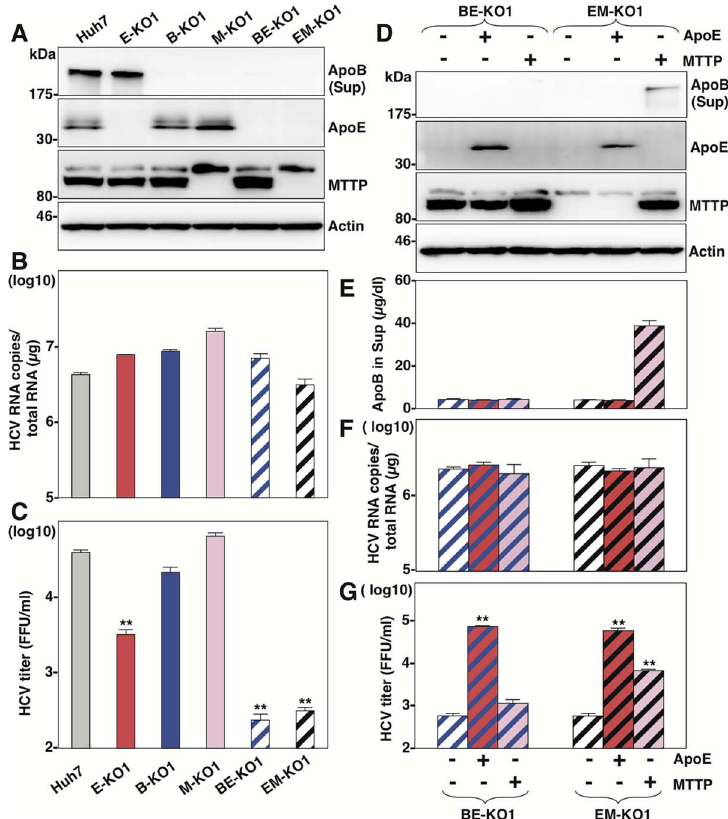
Figure 3. MTTP participates in the formation of infectious HCV particles through the maturation of ApoB. (A) Expressions of ApoB, ApoE and MTTP in Huh7, B-KO1, M-KO1, E-KO1, BE-KO1 and EM-KO1 cells were determined by immunoblotting analysis. Cells were infected with HCVcc at an MOI of 1, and intracellular HCV RNA (B) and infectious titers in the supernatants (C) were determined at 72 h post-infection by qRT-PCR and focus-forming assay, respectively. The expressions of ApoB, ApoE and MTTP in BE-KO1 and EM-KO1 cells with/without expression of ApoE or MTTP by lentiviral vector were determined by immunoblotting (D) and ELISA (E). Cells were infected with HCVcc at an MOI of 1, and intracellular HCV RNA (F) and infectious titers in the supernatants (G) were determined at 72 h post-infection by qRT-PCR and focus-forming assay,